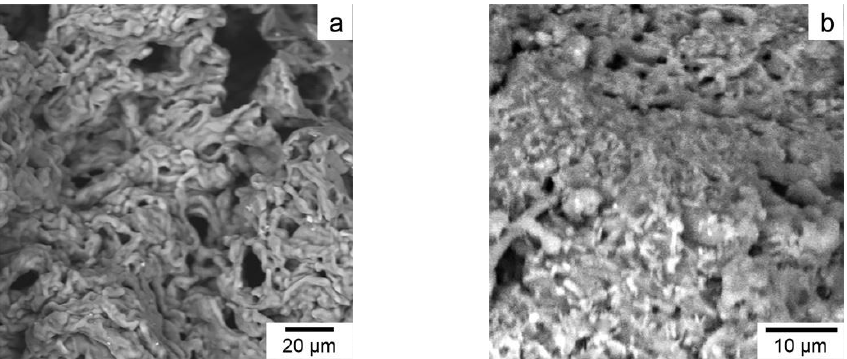
Figure 6. Scanning electron micrograph for the poly(VT-co-Na-VSA) ( a ) and AgNPs nanocomposite ( b ).